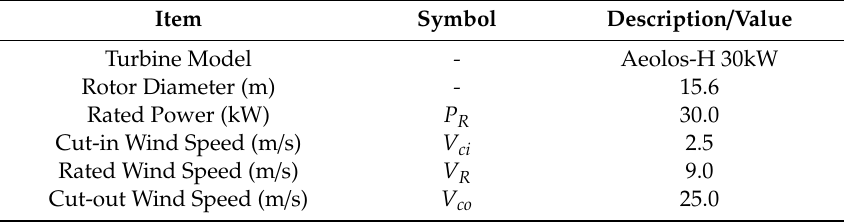
Table 10. Technical specifications of the selected wind turbine.